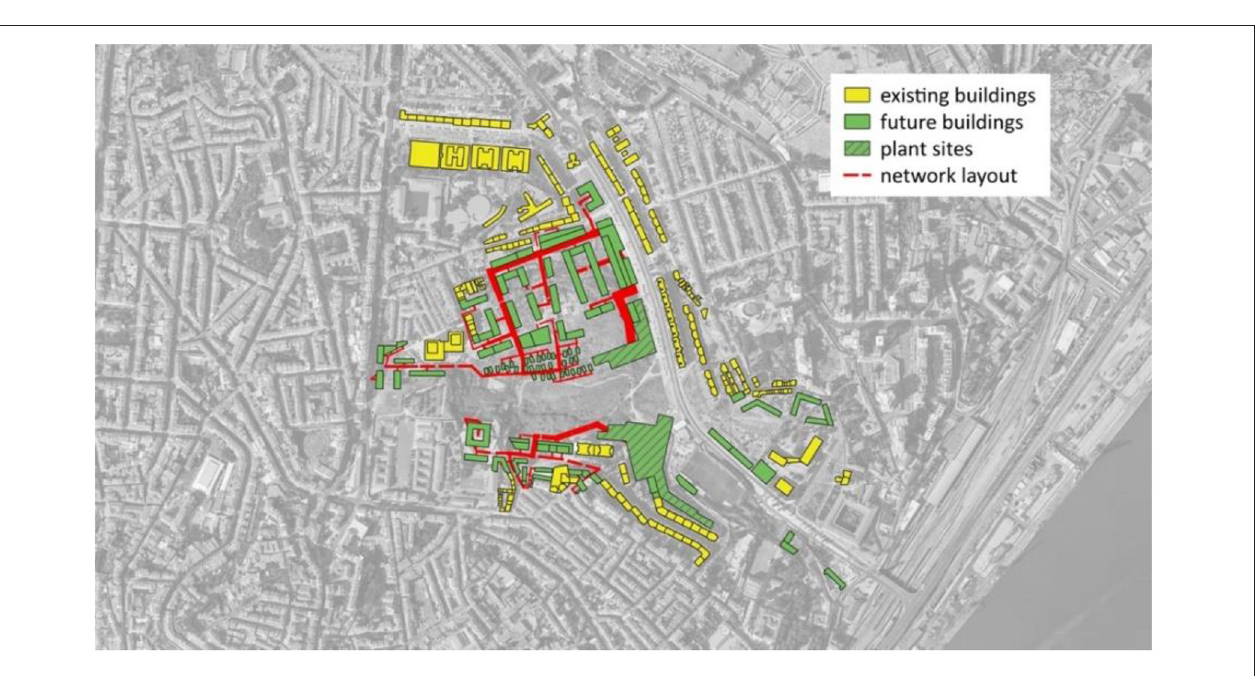
FIGURE 11 | Optimized two-layout